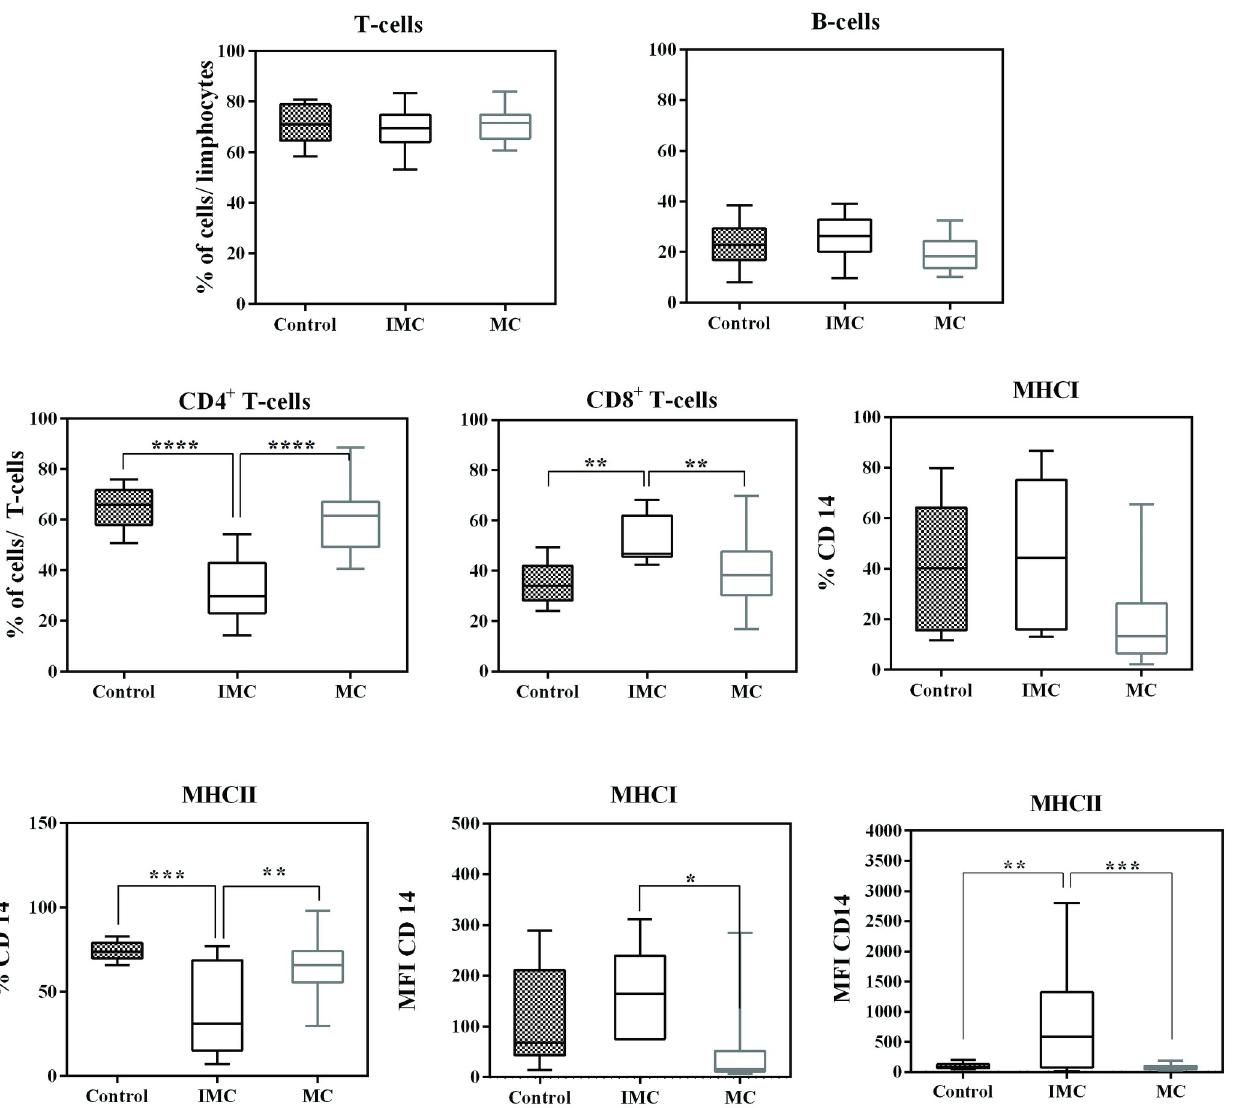
Fig 3. Leucocyte subsets in the peripheral blood of female dogs with mammary carcinoma. Results are shown in box plot format, depicting frequencies of CD4+, CD8+, CD21+ T-lymphocytes, as well as CD14+CD45+, CD14+ MHC-I+ CD14+ MHC-II+ monocytes, and MFI MHCI and MFI MHC-II. Significant differences (P < 0.05) are indicated by � , P < 0.01 is indicated by �� , P < 0.001 is indicated by ��� and P < 0.0001 is indicated by ����